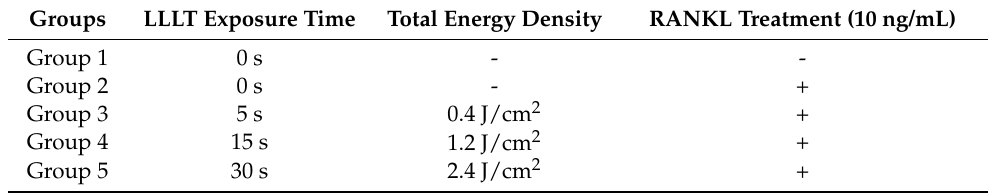
Table 1. LLLT irradiation parameters and RANKL